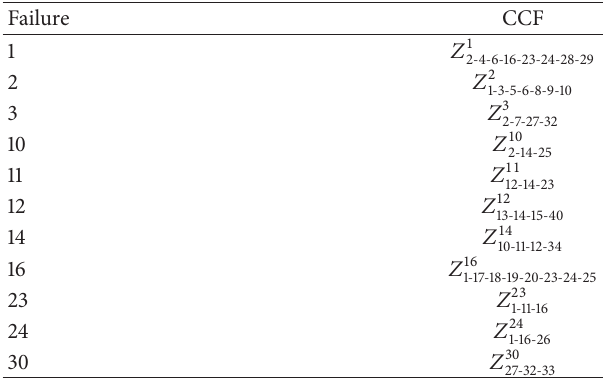
Table 2: The components of high-speed train bogie system. Table 3: Statistics of common cause